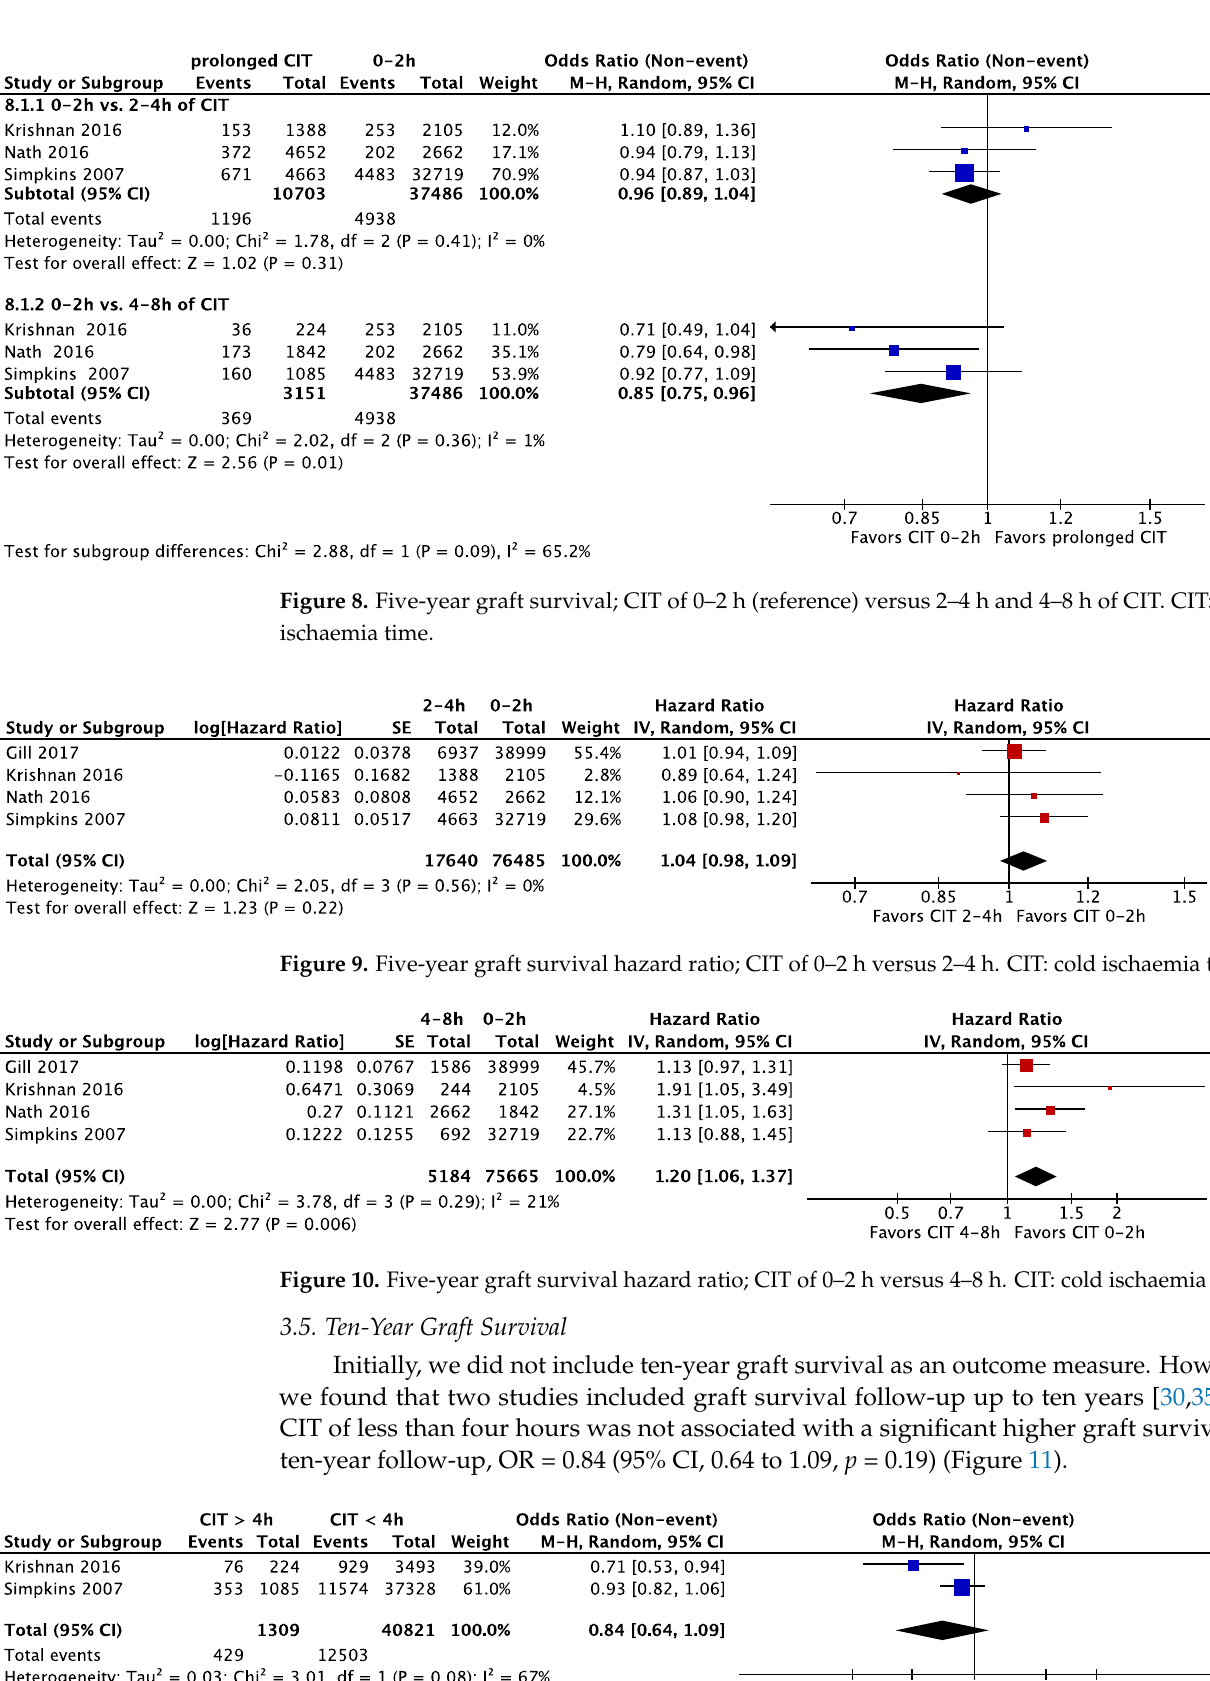
Figure 10. Five-year graft survival hazard ratio; CIT of 0–2 h versus 4–8 h. CIT: cold ischaemia time.